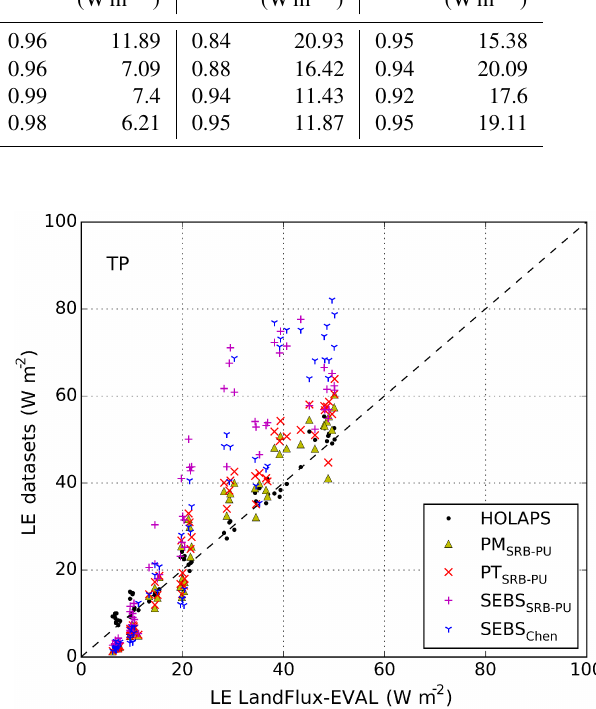
Figure 9. The monthly mean scatter plots of LE between the LandFlux-EVAL benchmark product and other products over the whole